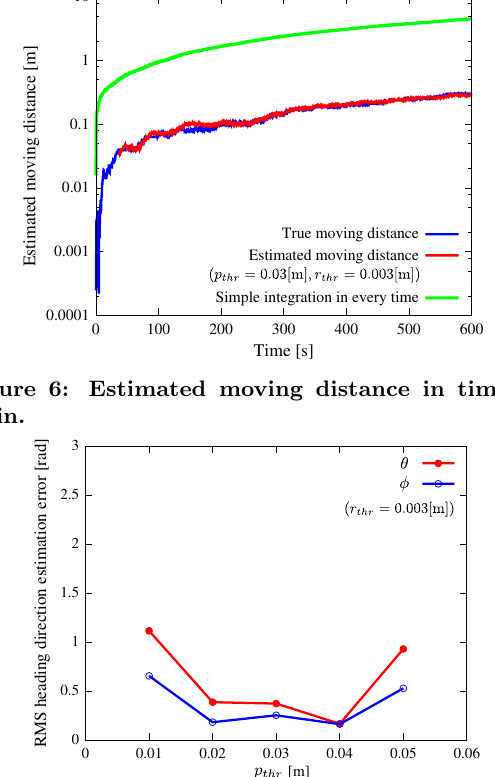
Figure 5: Moving distance estimation performance.